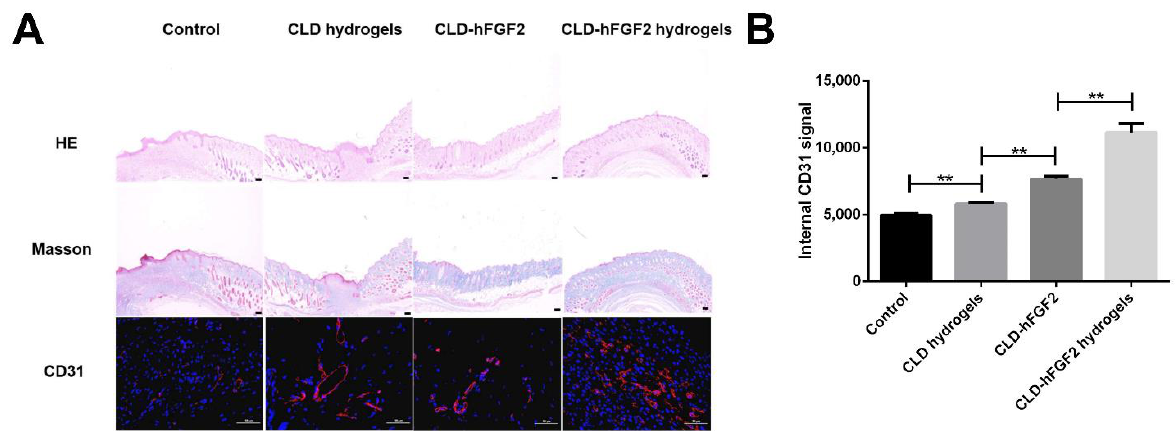
Figure 5. Granulation tissue, collagen, and expression of CD31 for different groups on the wound healing on the 8th day. (A) Images of HE, Masson and CD31 after covering with PBS, CLD hydrogel, CLD-hFGF2 and CLD-hFGF2 hydrogel. (B) Visualization of data on CD31 signals. (n = 4, ** p < 0.01) (HE and Masson staining are shown at 4 × 10 magnification, scale bar = 50 μm; CD31 staining is shown at 40 × 10 magnification, scale bar = 50 μm).